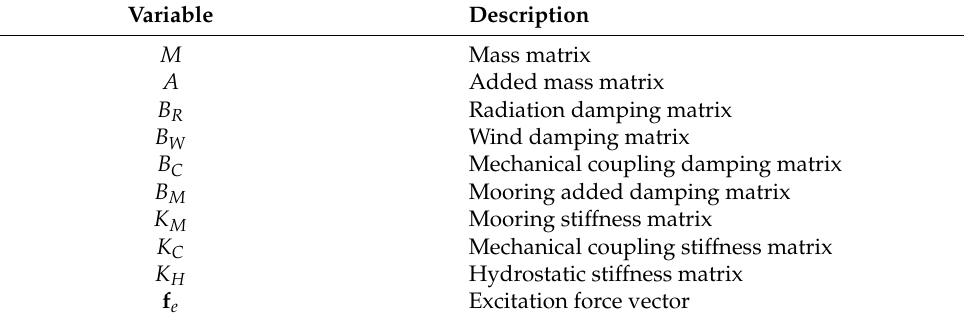
Table 3. Frequency domain